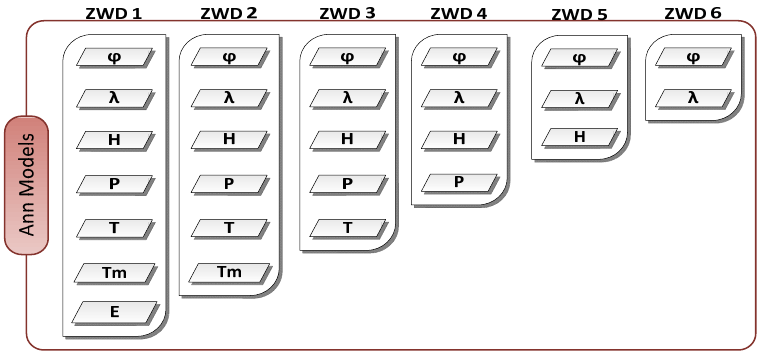
Figure 1. Artificial neural network (ANN) models.